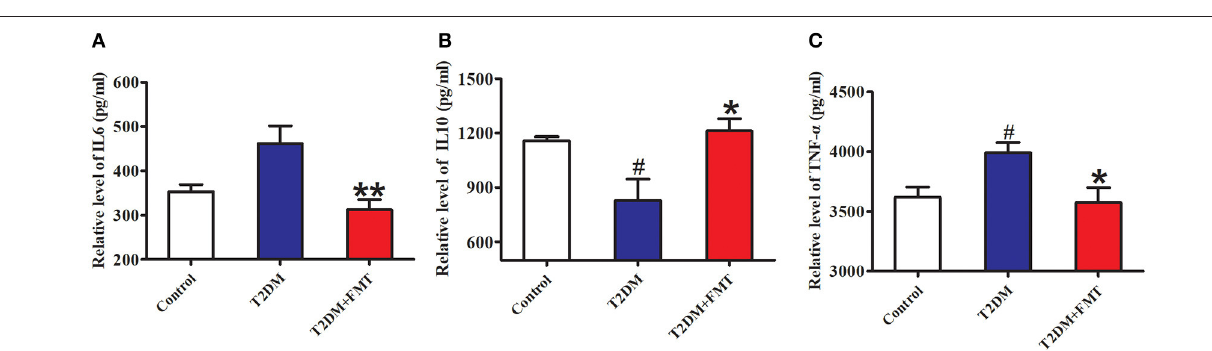
FIGURE 4 | The content of pro-inflammatory and anti-inflammatory cytokines. (A) The content of IL-6 in pancreas detected by ELISA. (B) The content of IL-10 in pancreas detected by ELISA. (C) The content of TNF- α in pancreas detected by ELISA. * P < 0.05 vs. T2DM, ** P < 0.01 vs. T2DM, # P < 0.05 vs. Control, n = 4–6. intake of intestinal probiotics could effectively improve such as short-chain fatty acids, were significantly different intestine microecology disorder, and relieve the symptoms of between type 2 diabetic and normal hosts (Salek et al., diabetic 2007). Many intervention studies have shown that the